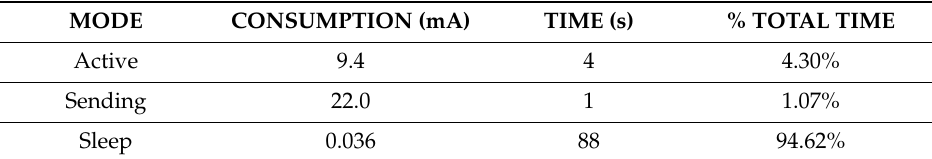
Table 3. Average power consumption (mA) for the di ff erent